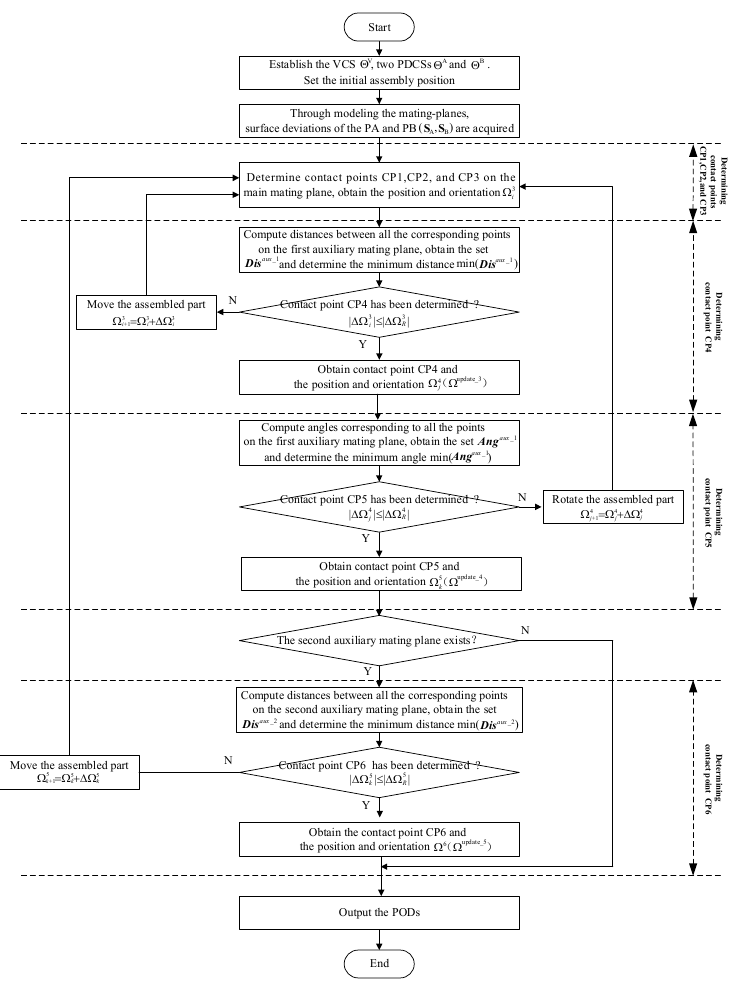
Figure 7. Flowchart of the approach based on successively determining contact points. VCS, view coordinate system. PDCS, part definition coordinate system.